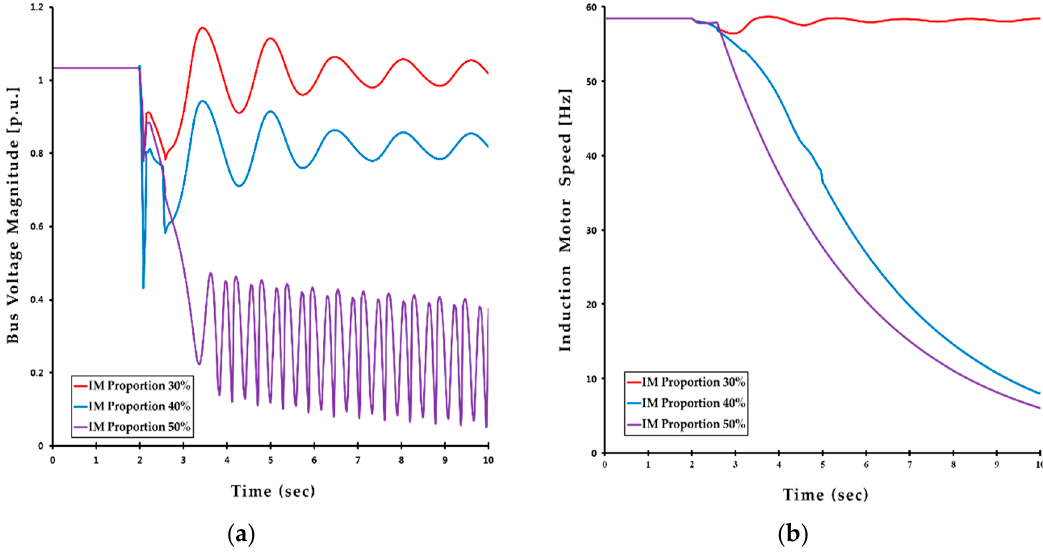
Figure 6. Effect of IM loads proportion on power systems. ( a ) Bus voltage magnitude. ( b ) IM speed.